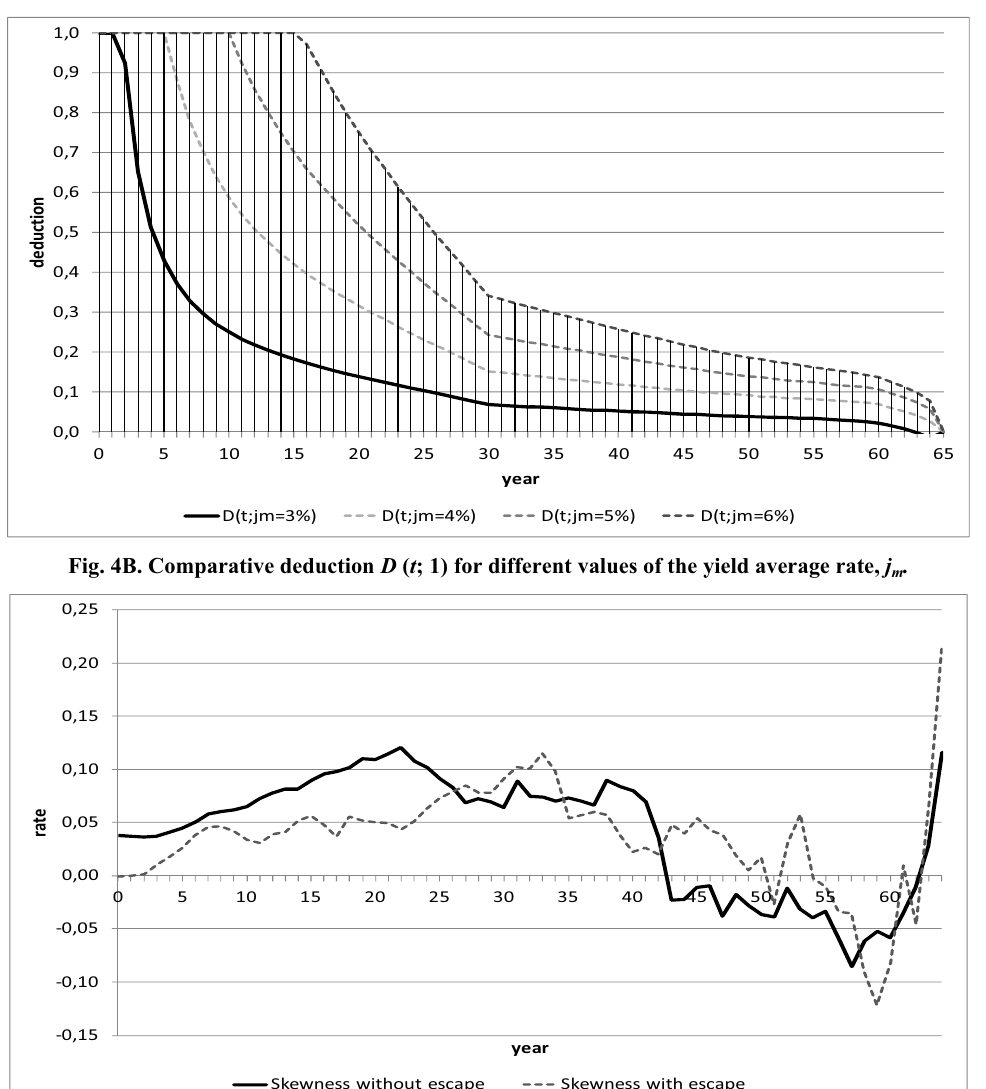
(cid:5) U evaluated in presence and in absence of contracts t